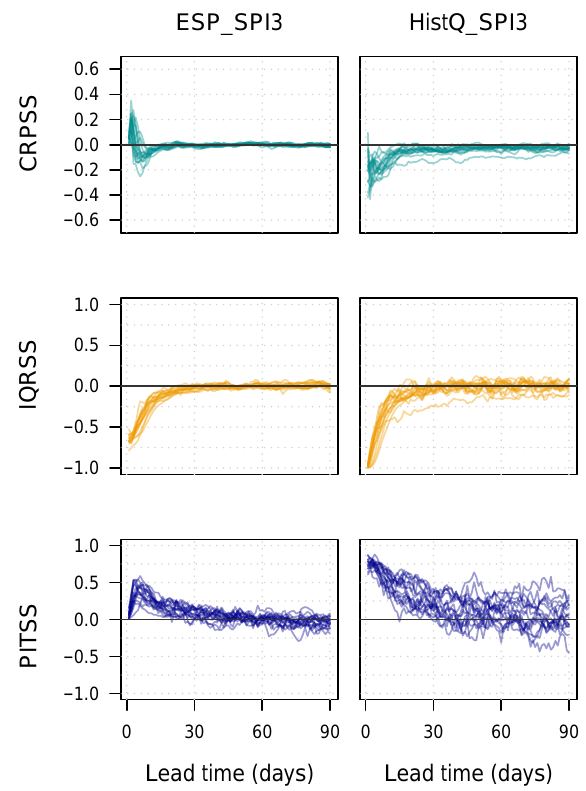
Figure 6. Skill scores (CRPSS, IQRSS, PITSS) of the conditioned ensemble forecast scenarios: ESP_SPI3 and HistQ_SPI3. In the skill scores, the reference forecast is the base ensemble Sys4. Each line represents one of the 16 catchments